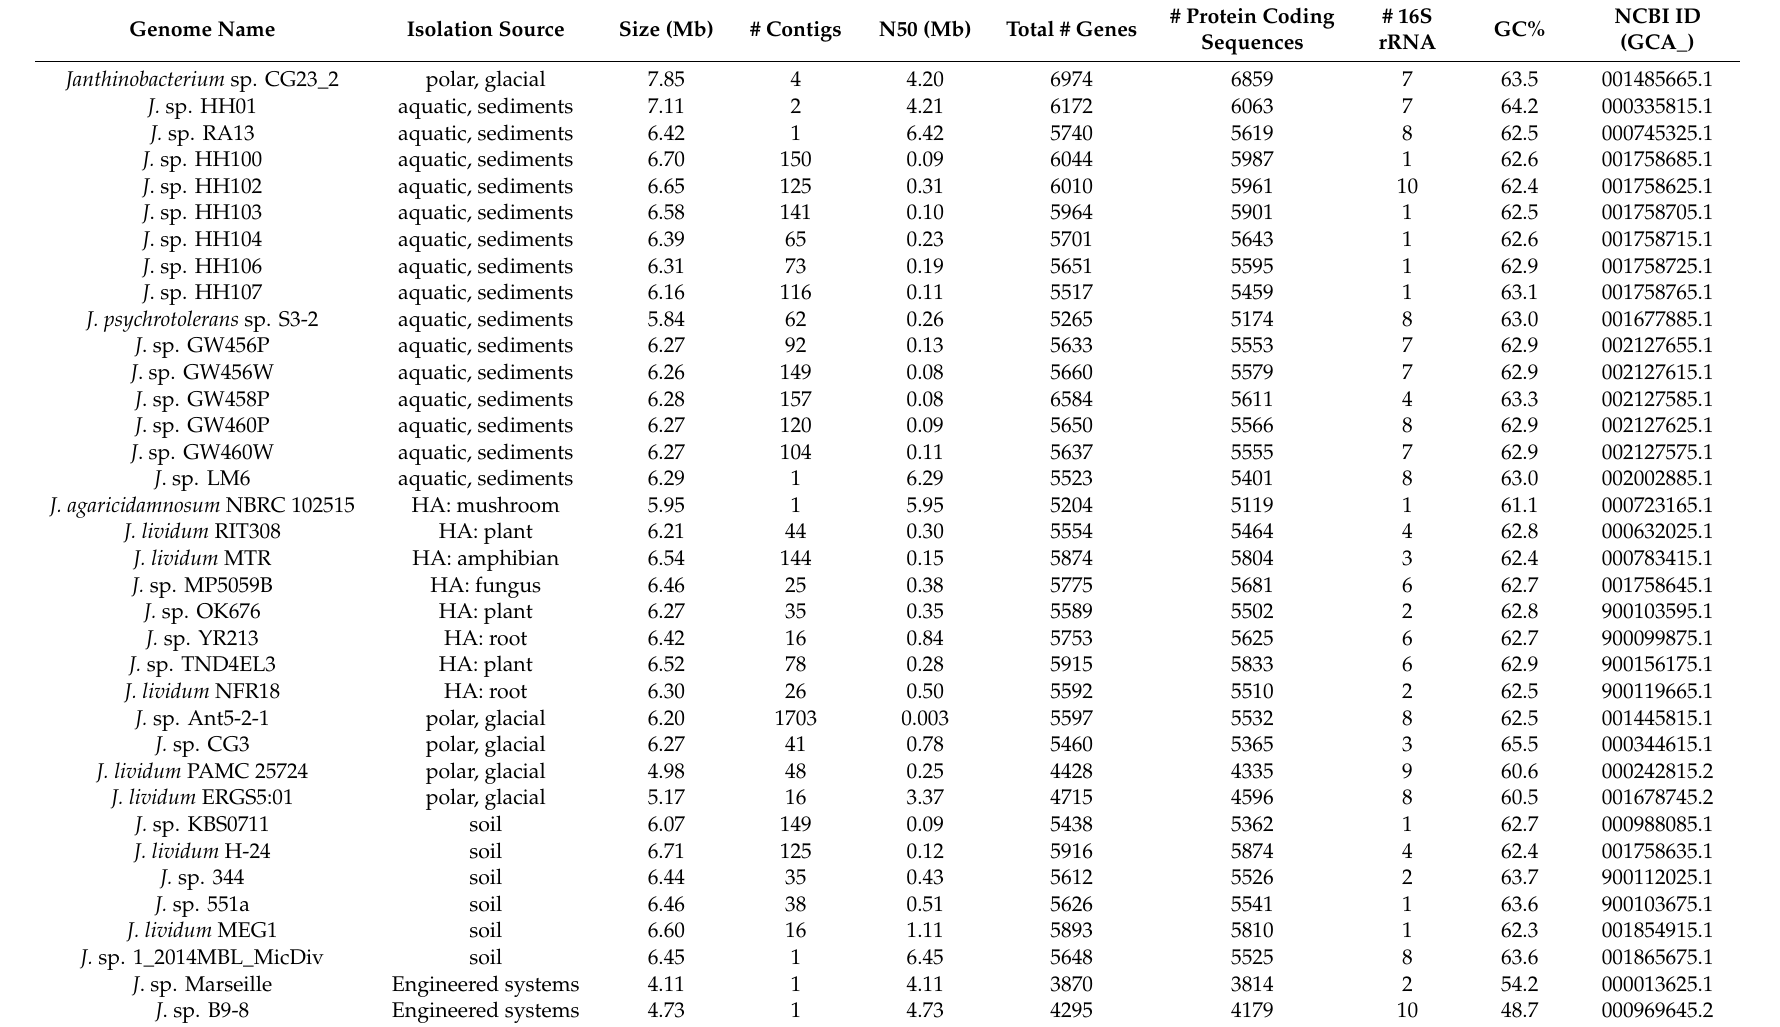
Table 1. Summary of the 36 Janthinobacterium genome statistics. (HA: